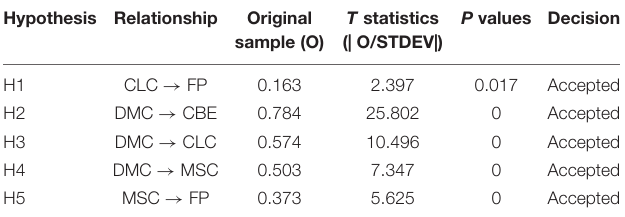
TABLE 3 | Direct relationship.